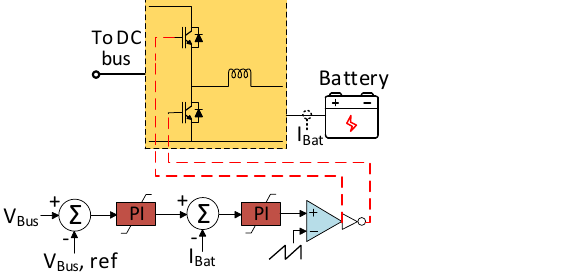
Figure 7. The control algorithm for the battery in the BOS.